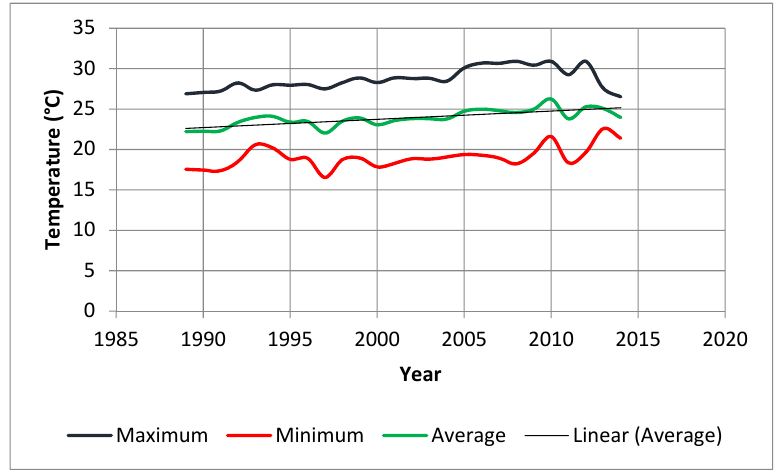
Figure 7. Rainfall trend of Udayapur Gadhi station.